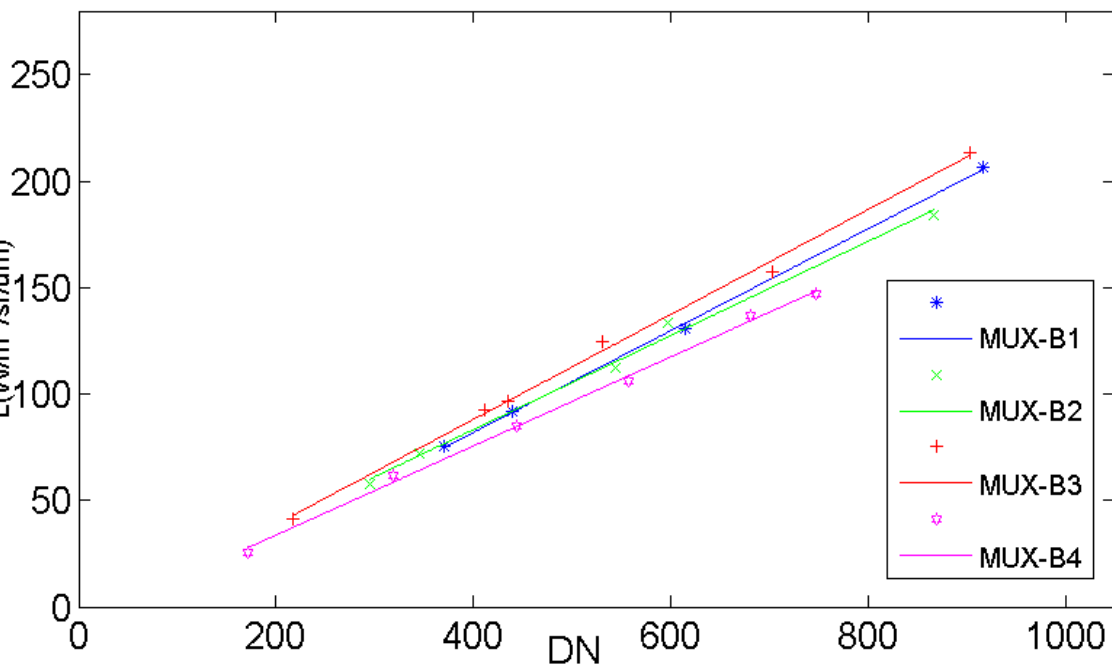
Figure 10. Calibration result of the radiometric calibration tarps (coefficient B). The last coefficient (coefficient C, as shown in Figure 11) was determined by combining permanent artificial targets and radiometric calibration tarps, which means that there would be seven gray-scale targets and two color-scaled targets. All the calibration results show that linear correlations between DN and TOA radiances of ZY3-02 MUX are very high, with a correlation coefficient R 2 value of up to 0.99 for each